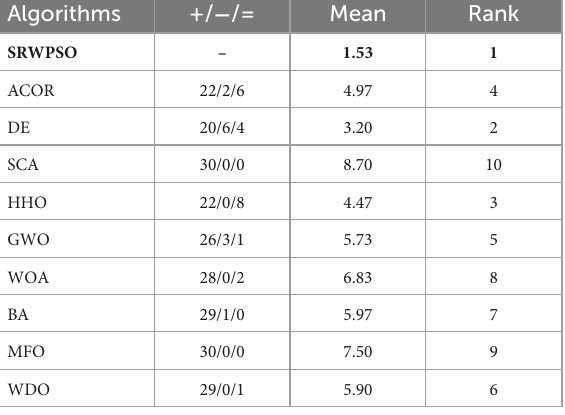
TABLE 7 The results of the Wilcoxon signed-rank test of SRWPSO with traditional algorithms.